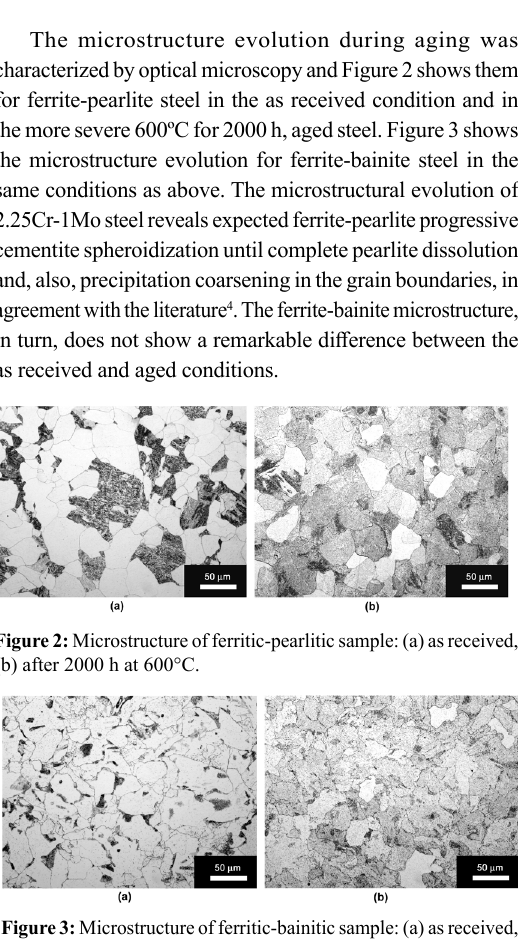
Figure 1: Creep curves for the 2.25Cr-1Mo steels tested. Averages minimum creep rates: (3.4 ± 1.3) ×10 -3 %h -1 for ferritic-bainitic microstructure, and (4.6 ± 0.8) ×10 -4 %h -1 for ferritic-pearlitic microstructure.